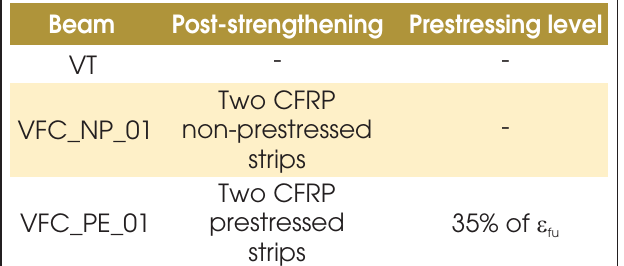
Figure 5 – Rupture of FRP close to a flexural crack tip FISSURA